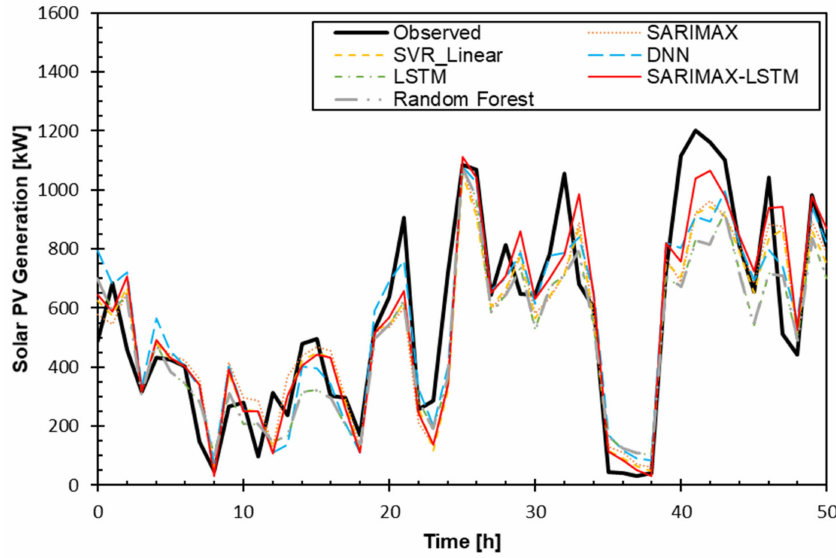
Figure 8. The result of multisite solar PV generation prediction of each